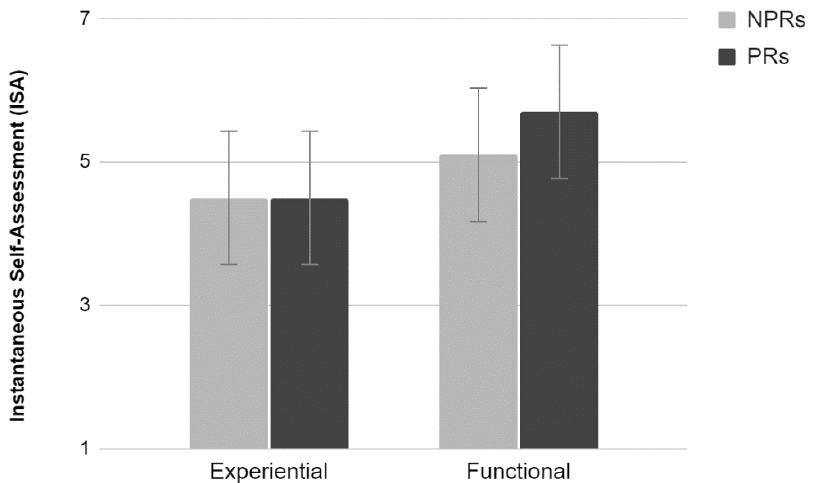
Figure 5. ISA scale score by Experience (NPRs vs. PRs) and Test (Experiential vs. Functional). Error bars denote 0.95 confidence intervals.